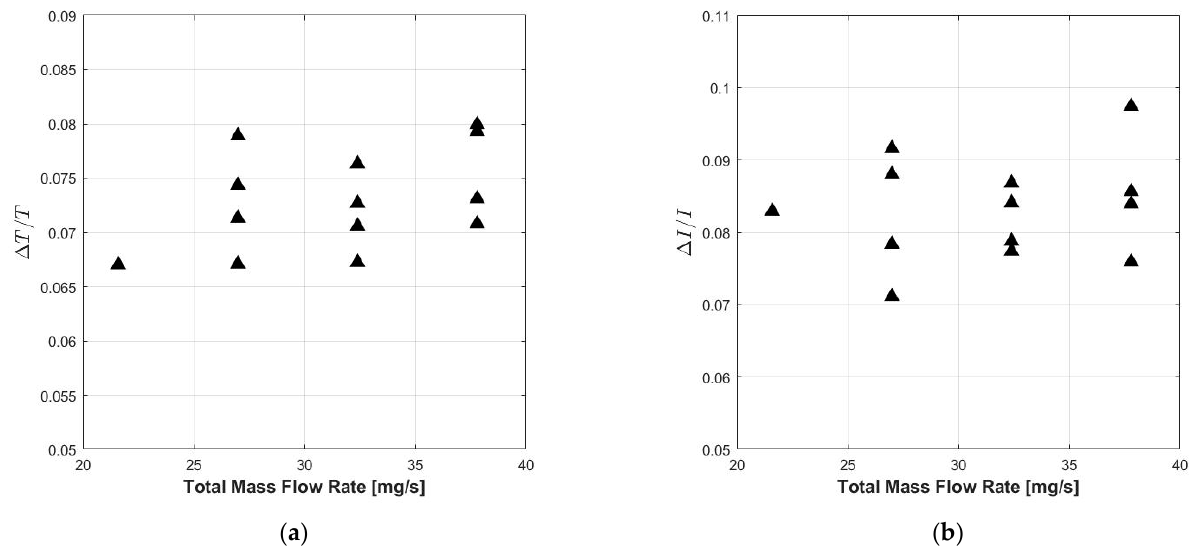
Figure 9. Variations of thrust ( a ) and discharge current ( b ) as a function of the total mass flow rate for all the tested points on the HT20k M configuration. The changes stayed in the 6–8% range for the thrust and 7–10% for the discharge current.